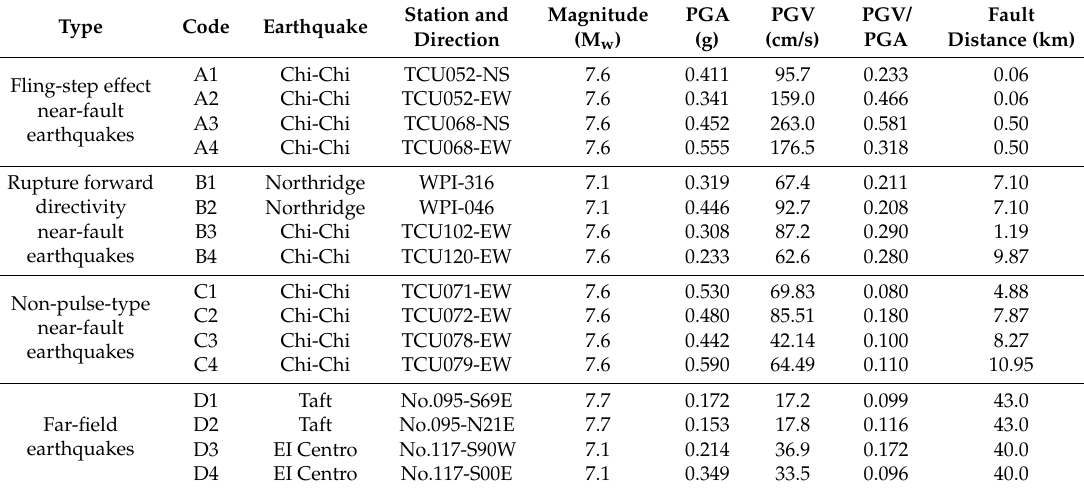
Table 1. Earthquake records and their characteristic parameters.